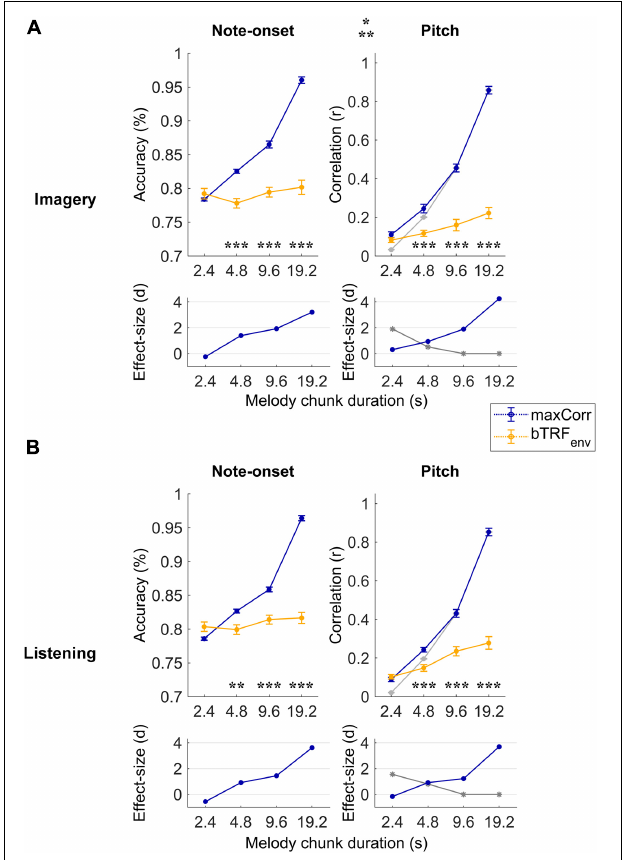
FIGURE 2 | Robust note and pitch decoding from EEG. Melody decoding scores obtained with maxCorr from EEG data filtered between 0.1 and 30 Hz are compared with scores obtained when using backward envelope TRFs (bTRF env ) for the imagery (A) and listening (B) conditions. Decoding accuracies are reported for note timing (left) and decoding correlation values for note pitch values (right). As expected, decoding scores were higher for maxCorr than bTRF env (three-way repeated measures ANOVA p < 0.001, post hoc Tukey’s HSD; * p < 0.05, ** p < 0.01, *** p < 0.001). Grey lines indicate the pitch decoding correlation scores with the maxCorr method when pitch information was shuffled among segments with identical timing. Scores larger than this baseline indicate that the decoding is partially driven by pitch-related EEG information. Bottom panels indicate the effect size (Cohen’s d) of the comparison between maxCorr and bTRF env (blue solid lines) and between maxCorr and the maxCorr baseline after shuffling the pitch values (grey solid lines). Note that longer segments would lead to smaller reference sets, thus potentially affecting the decoding baseline. This potential confound was solved by randomly resample the reference set to the size of the smallest set across all segment durations (see section “Materials and Methods”). Supplementary Figure 1 shows the results of this analysis for EEG filtered in the frequency band 1–30